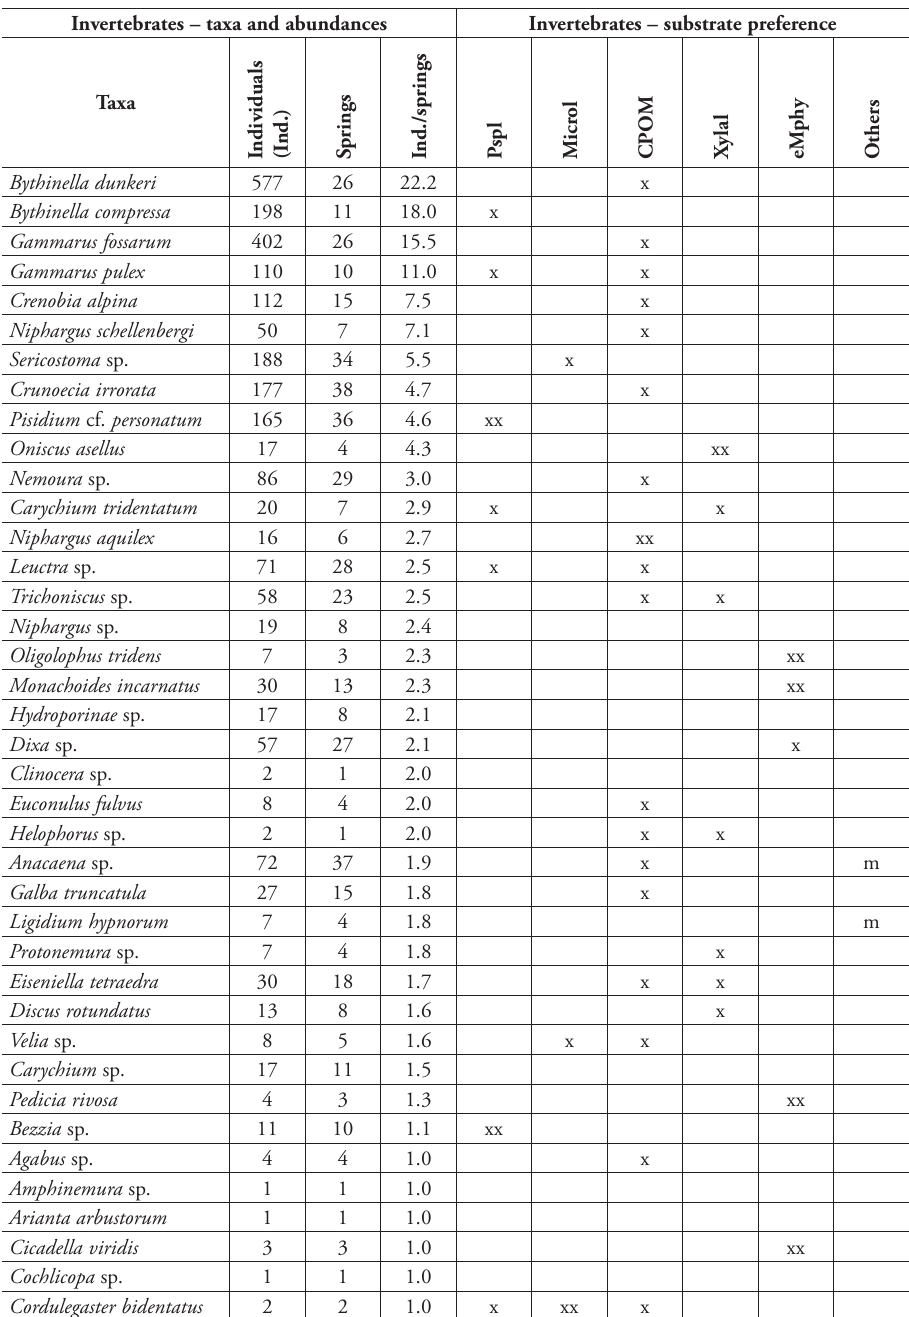
Table 4. Taxa list of springs within deciduous forest land cover. x – good substrate type preference identifica- tion; xx – very good substrate type preference identification; m – mosses (spring dwelling taxa are in bold). Invertebrates – taxa and